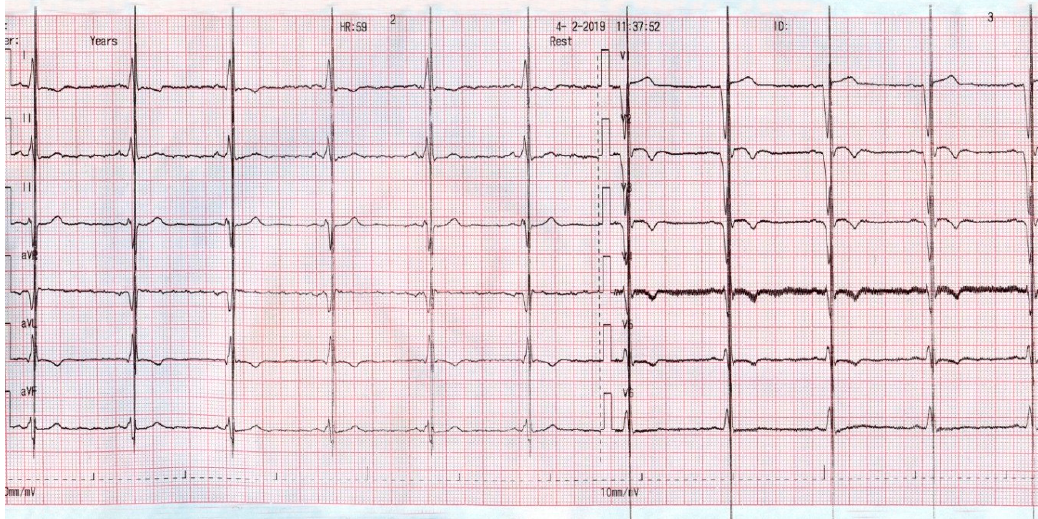
Figure 3. ECG aspect of a patient with sinus rhythm supported with an ICD and CCM.